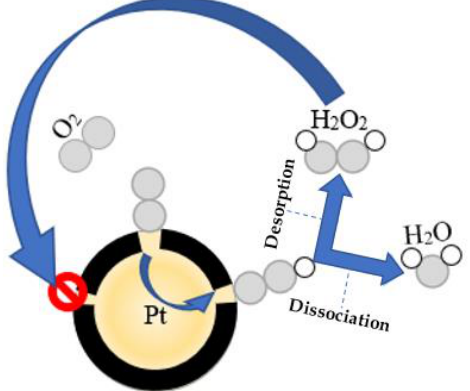
Figure 13. Effect of a carbon coating on Pt/C catalysts surface by acetylene CVD, and H 2 O 2 selectivity depending on the CVD operation time for Pt/C catalysts. Adapted from [272].